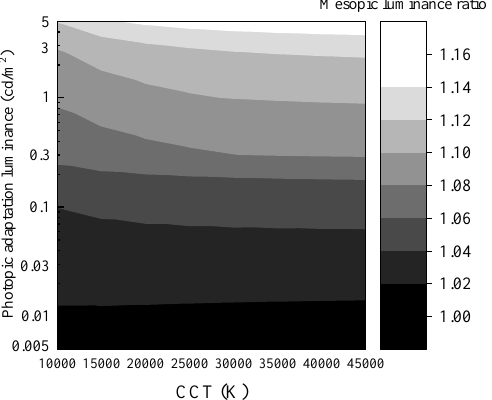
Figure 7. R sp variations for CCTs in the range from 10000 to 45000K and ratio of R sp s in 10- and 2-degree SSC systems as a function of CCT.